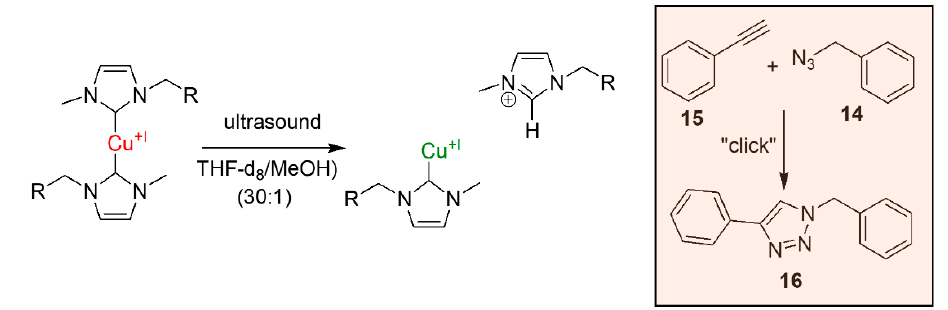
Figure 6. Activation of the latent catalyst is achieved by ultrasonication which cleaves one of the two shielding NHC ligands. This allows the alkyne to coordinate to the Cu(I) and the “click” reaction can take place. As a model reaction, the “click” reaction between benzyl azide ( 14 ) and phenylacetylene ( 15 ) was chosen.